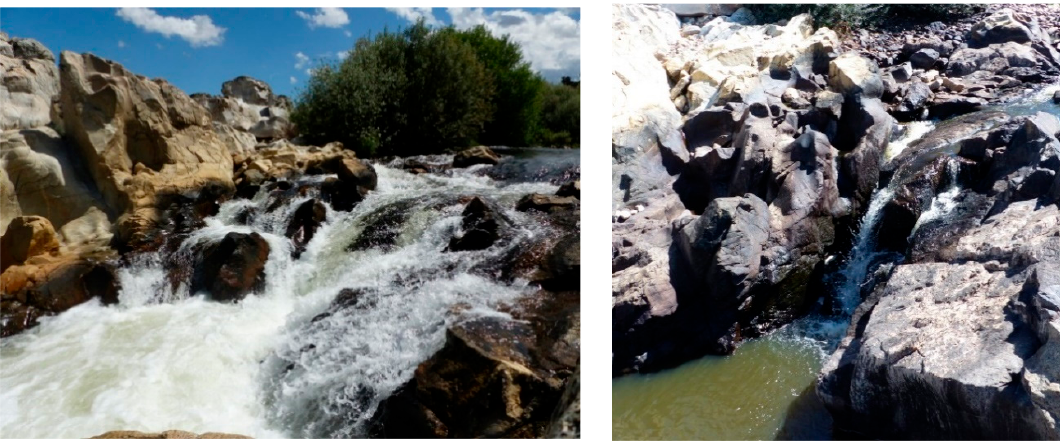
Figure 4. Waterfall downstream of the dam. On the left, a photograph taken on 30 May 2017 with a mean flow rate of 2.59 ± 0.17 m 3 / s. On the right, 30 August 2017 with a flow rate upstream of the dam of 0.021 m 3 /s.